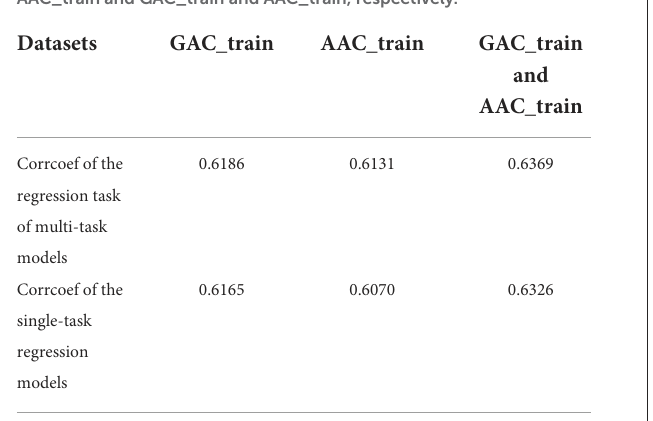
TABLE 8 The cross-validation Pearson correlation coefficient of single-task regression models and multi-task models on GAC_train, AAC_train and GAC_train and AAC_train, respectively.